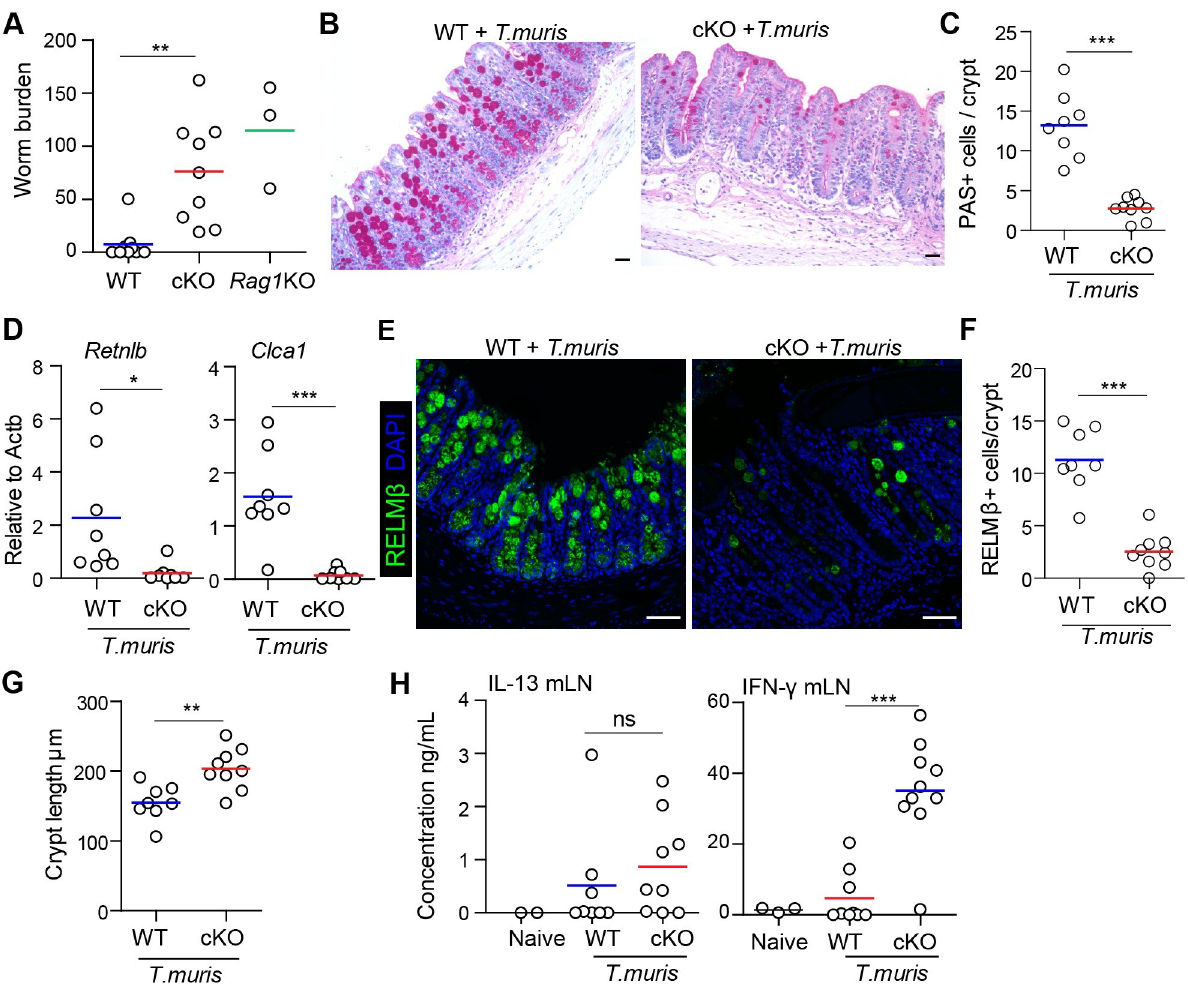
Fig 4. Intestinal-epithelial LSD1 is required for effective immunity against the whipworm Trichuris muris . (A) WT (n = 9), cKO (n = 9) and Rag1 KO (n = 3) mice were infected with 200 embryonated eggs of T . muris . Worm burden was quantified in caecum after 21 days of infection. Pooled from 2 independent experiments. (B) PAS staining for goblet cells was done in ceacal epithelium of WT and cKO mice after 21 days of T . muris infection. (C) Quantification of PAS+ cells in caecal epithelium of WT (n = 8) and cKO (n = 9) mice after 21 days of T . muris infection. (D) RT-qPCR for Retnlb and Clca1 in proximal colon of WT (n = 8) and cKO (n = 8) after 21 days of T . muris infection. (E&F) Representative confocal images and quantification of RELM β + cells (green) in caecum tissue of WT (n = 8) and cKO (n = 9) mice infected with T . muris for 21 days. DAPI (blue) was used as a nuclear counter stain. Scale bar = 50 μ m. (G) Measurement of cecal crypts length in WT (n = 8) and cKO (n = 9) mice infected with T . muris for 21 days. (H) Sandwich ELISA for quantification of IL-13 and IFN- γ expression in restimulated mesenteric lymph node cells after 21 days of T . muris infection. Unpaired two-tailed Student’s t test (A, C, D, F&G) and one-way ANOVA (H) was performed to observe significant differences. ns = not significant, � P � 0.05, �� , P < 0.01, ��� P �